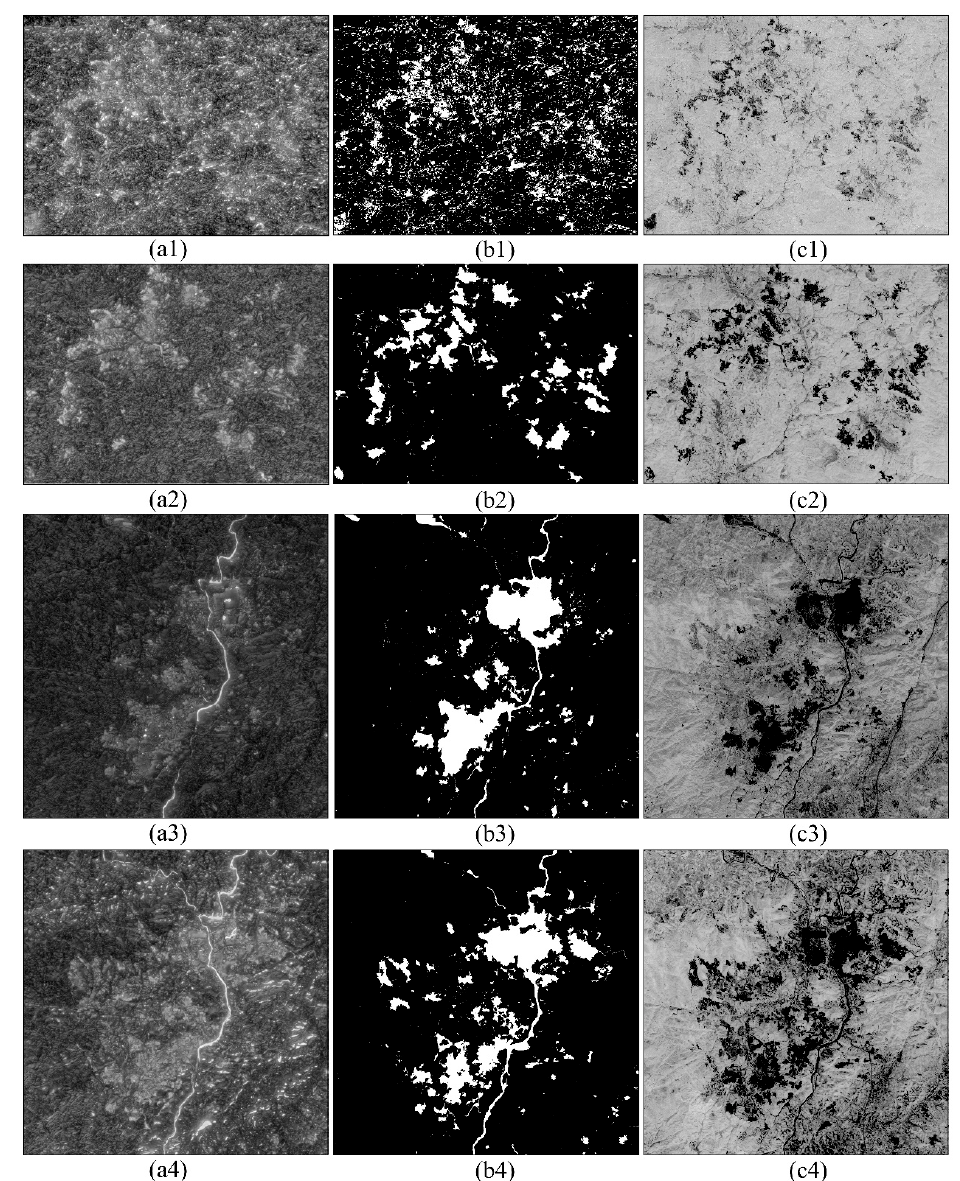
Figure 4. Saliency map and NDVI (Normalized Di ff erence Vegetation Index). ( a1 – c1 ) Saliency map and NDVI of the GF-1 image in Lingbei; ( a1 ) saliency map; ( b1 ) salient region; ( c1 ) NDVI; ( a2 – c2 ) saliency map and NDVI of ALOS image in Lingbei; ( a3 – c3 ) saliency map and NDVI of the GF-1 image in Shipai; ( a4 – c4 ) saliency map and NDVI of ALOS image in Shipai.